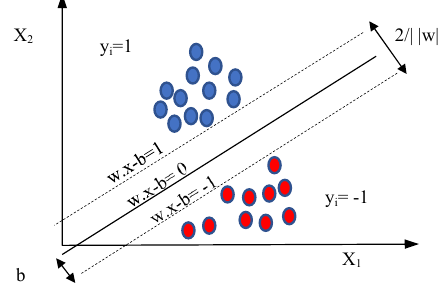
Figure 5. Maximum margin hyperplane (Bahga & Madisetti)